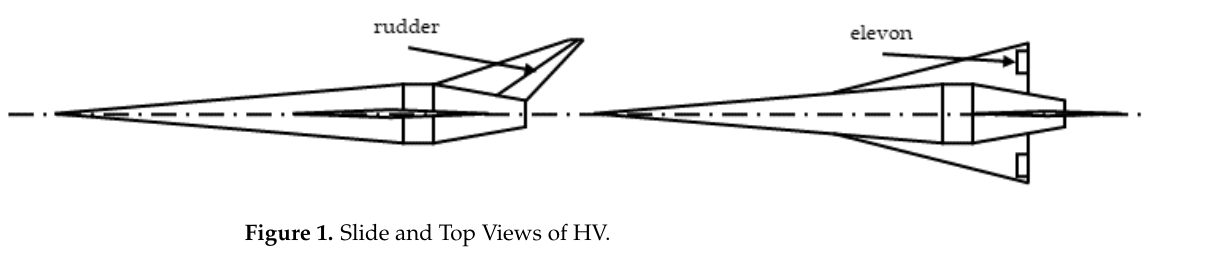
Figure 1. Slide and Top Views of HV. Table 1. Mass and Rotary Inertia of Hypersonic Vehicle.